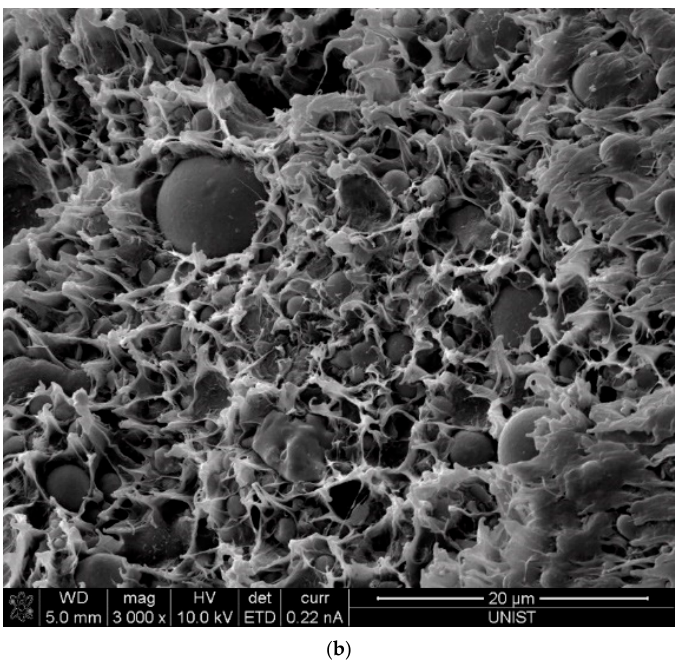
Figure 9. SEM images of the fractured surface ( a ) #1 and ( b ) #6.